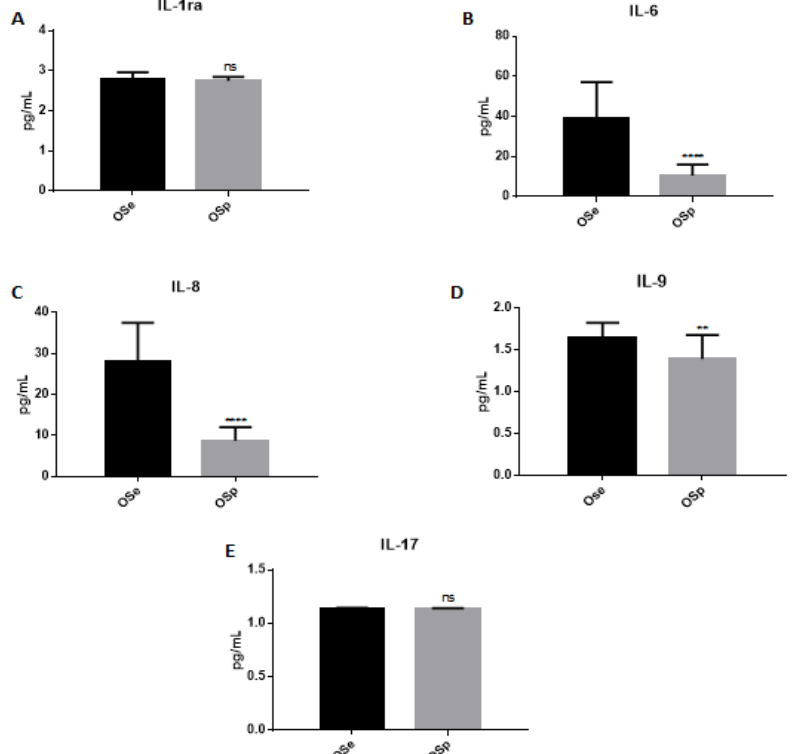
Figure 3. Evaluation of interleukins level in the serum of sedentary obese children (OSe) compared to obese children who played sport (OSp). ( A ) IL-1ra, ( B ) IL-6, ( C ) IL-8, ( D ) IL-9, ( E ) IL-17. The data are expressed as the means ± SDs. The significance was determined by the Student’s t -test: **** ( p < 0.0001) and ** ( p < 0.01) represent significance compared to sedentary obese children, ns ( p > 0.05), not significative compared to sedentary obese children.